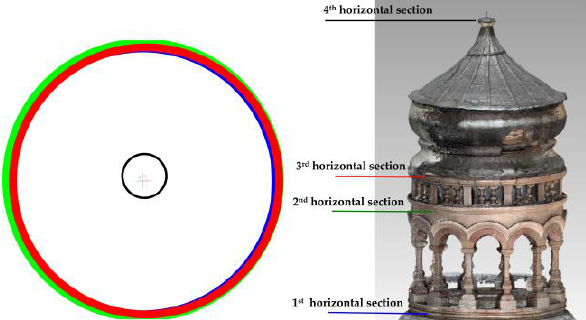
Figure 8: The horizontal sections of the upper dome of the Holy Aedicule